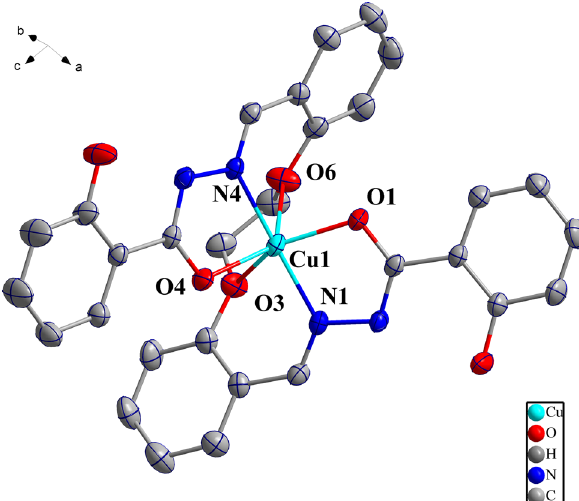
Synthesis of the ligand H L: 2 The ligand was synthesized from the reaction of 2-hydroxybenzohydrazide (304.30 mg, 0.02 mmol) and a dialdehyde [4] (270.28 mg, 0.01 mmol) according to the procedure reported earlier. Yield (350.06 mg, 65%).